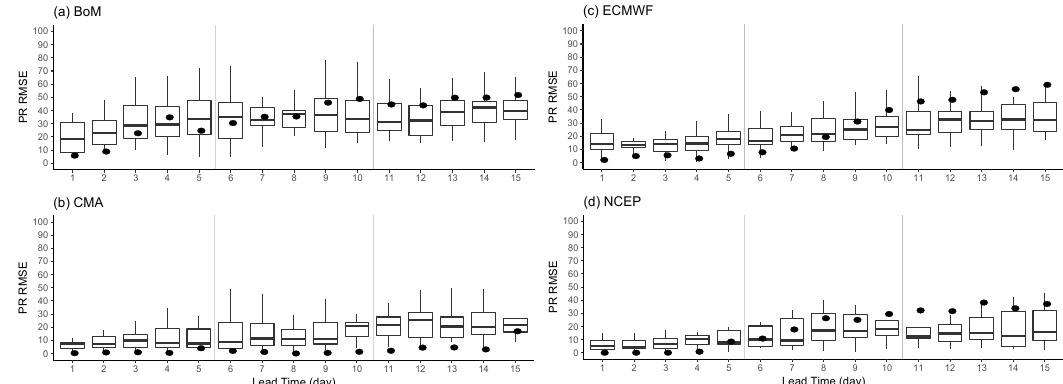
Figure 10. The root-mean-squared error (RMSE) calculated as the difference between the model forecast PR and the observed PR (as in Figure 9), termed as PR-RMSE. The boxes are formed by multiyear and multimember hindcast RMSE, and the black points represent the RMSE of the 2018/19 SPRE. Outliers estimated using Tukey fences [32] are illustrated in white circles.